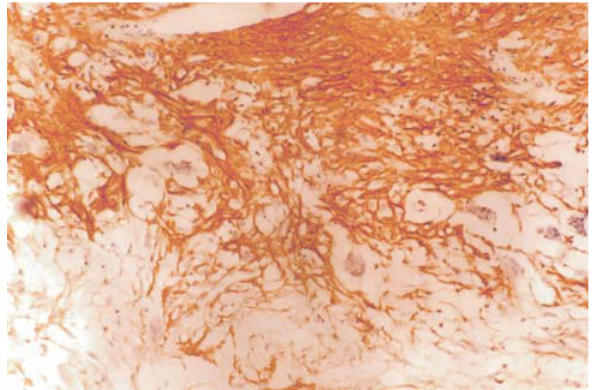
FIGURE 5 - Tenascin immunoreactivity expression in central giant cell granuloma of the jaws. Reticulate/fibrillar organization pattern (SABC – 100x)